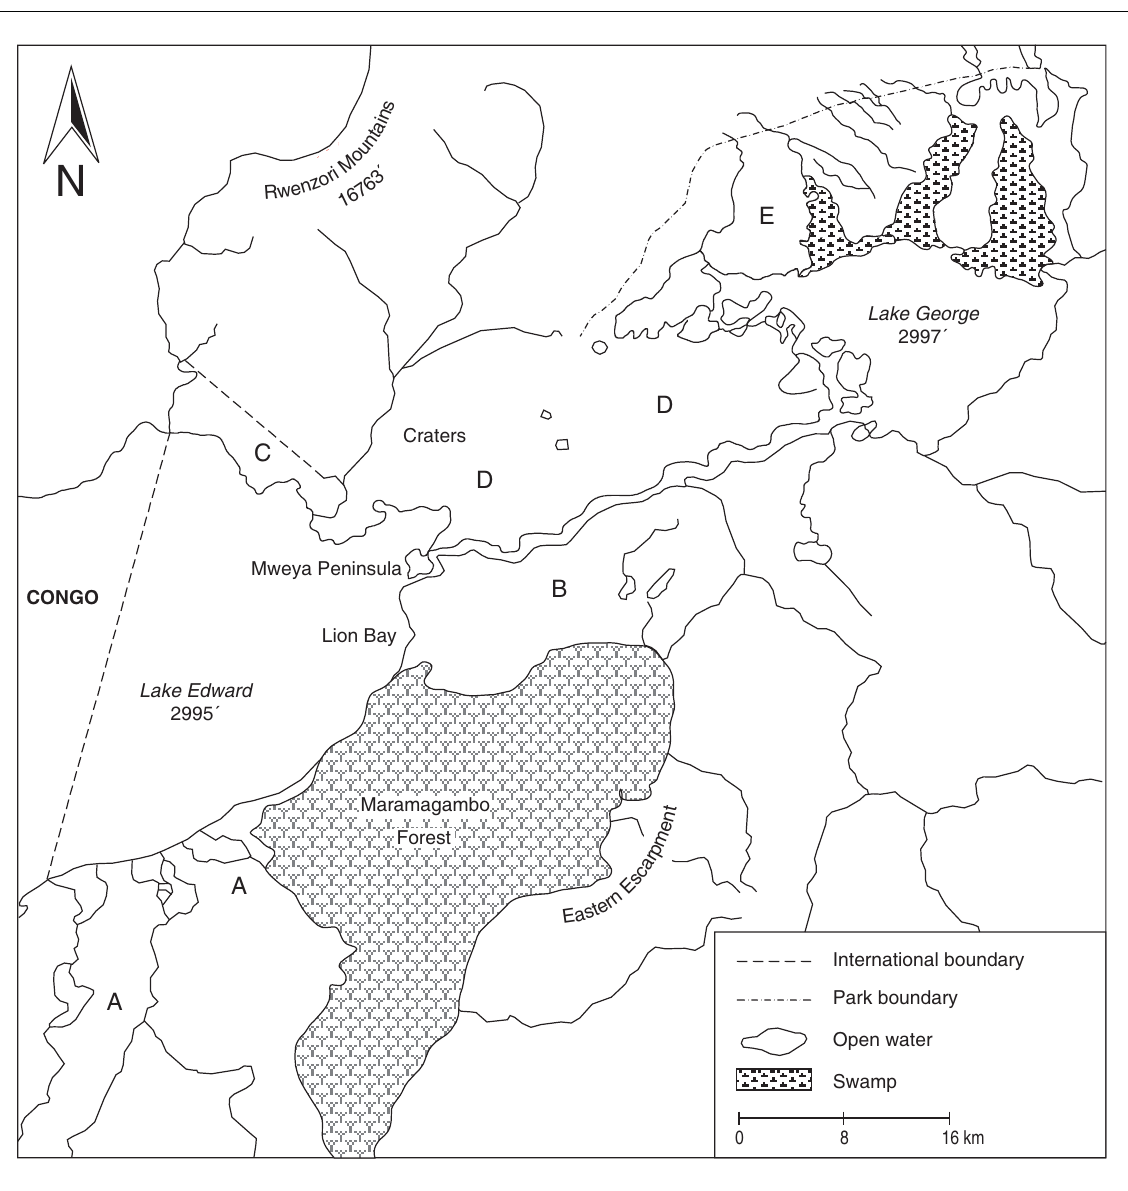
FIG. 2 Queen Elizabeth National Park, study